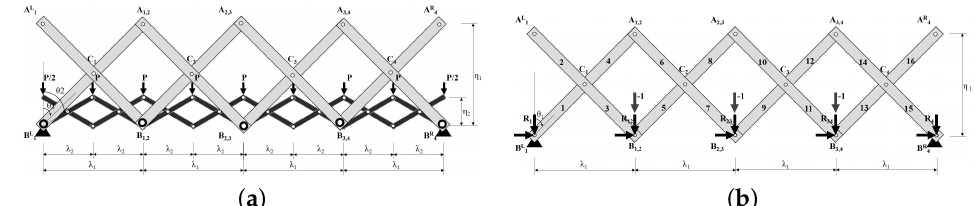
Figure 9. Assumptions of unit load P = 1 distributed to the coupling of a scissors-type structure.